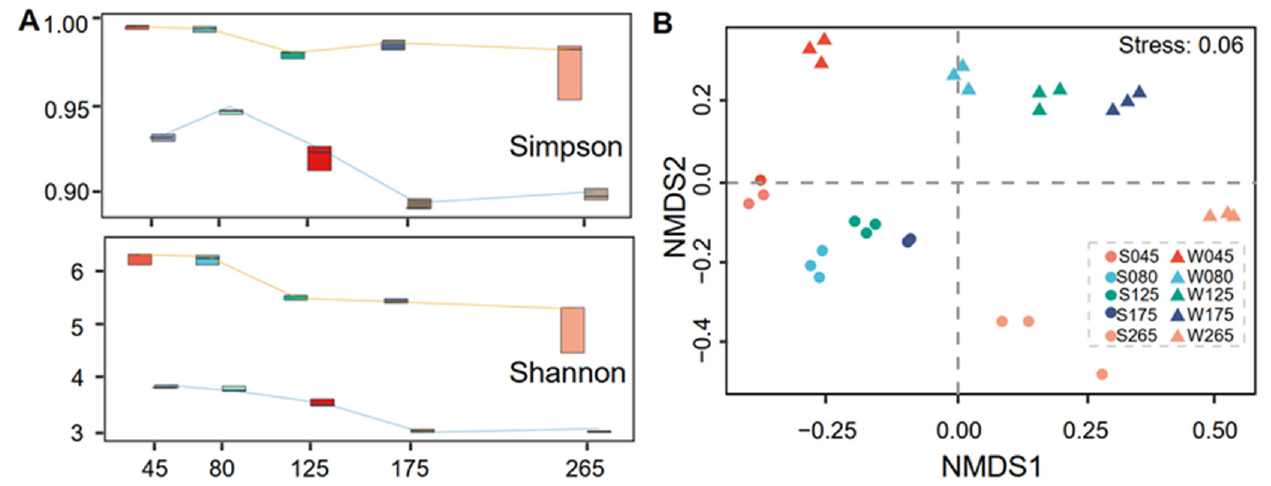
Figure 3. The biodiversity of the prokaryotic community. ( A ), The α diversities (Simpson and Shannon index) were analyzed by R package (microeco) and are displayed along a gradient of increasing salinity. The orange and blue lines represent sediment and water groups in salterns, respectively. ( B ), Non-metric multidimensional scaling (NMDS) was performed to exhibit the β -diversity of the prokaryotic community in salterns.